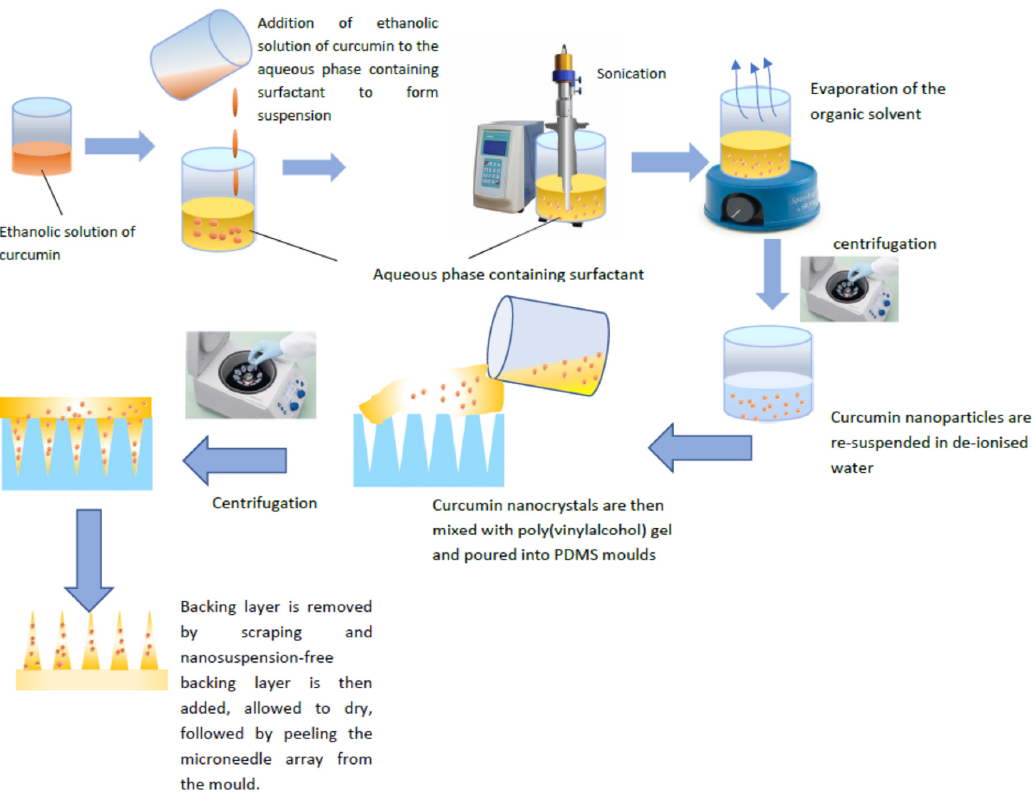
Figure 1. Schematic illustration of curcumin nanosuspension (CU-NS) and dissolving microneedles